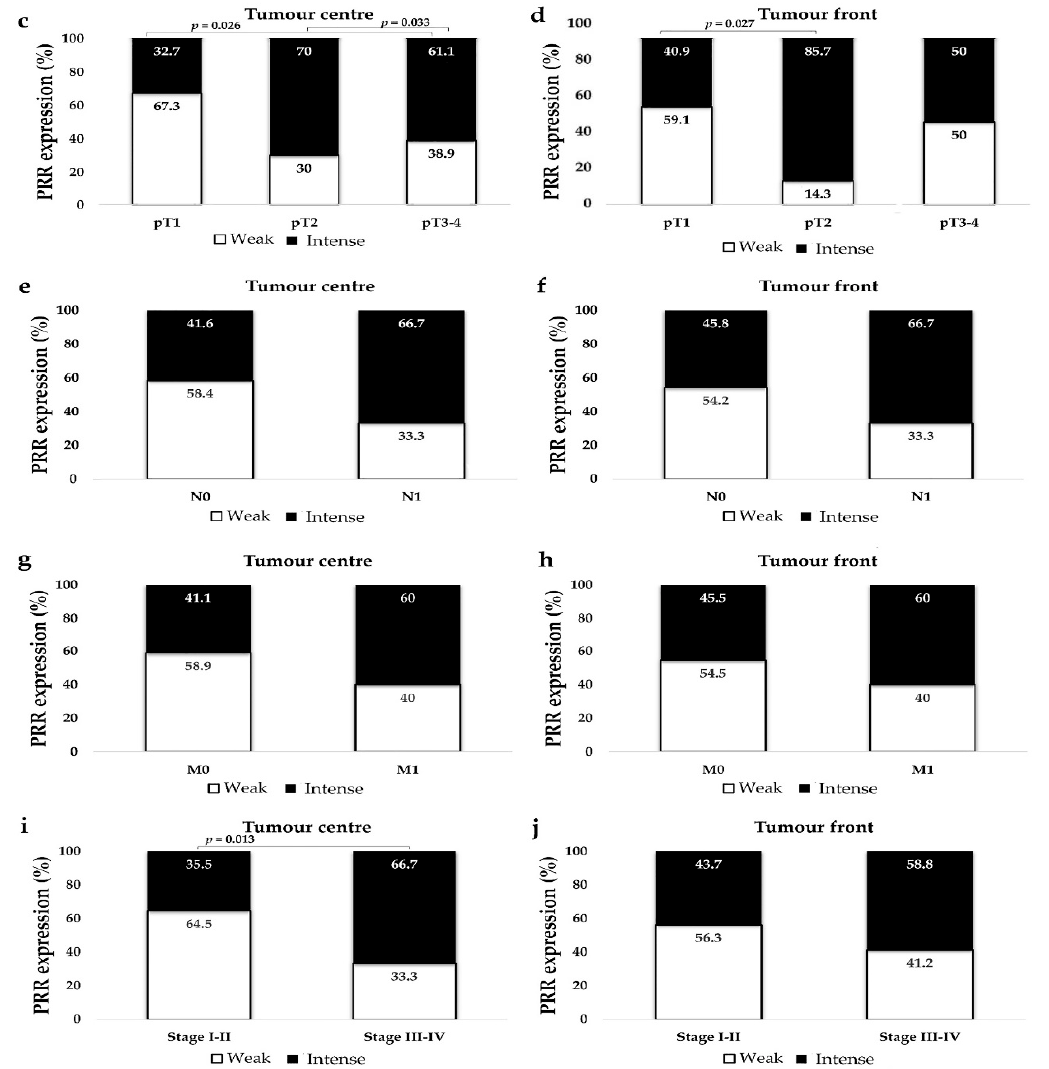
Figure 4. Immunohistochemical PRR staining according to CCRCC tumour size ( a , b ), local invasion (pT) ( c , d ), lymph node (N) ( e , f ) and distant metastasis (M) ( g , h ), and TNM Stage ( i , j ). PRR staining intensity was grouped as weak and intense. Chi-square test was used for data analysis. N0: No lymph node metastasis; N1: lymph node metastasis; M0: No distant metastasis; M1: distant metastasis.